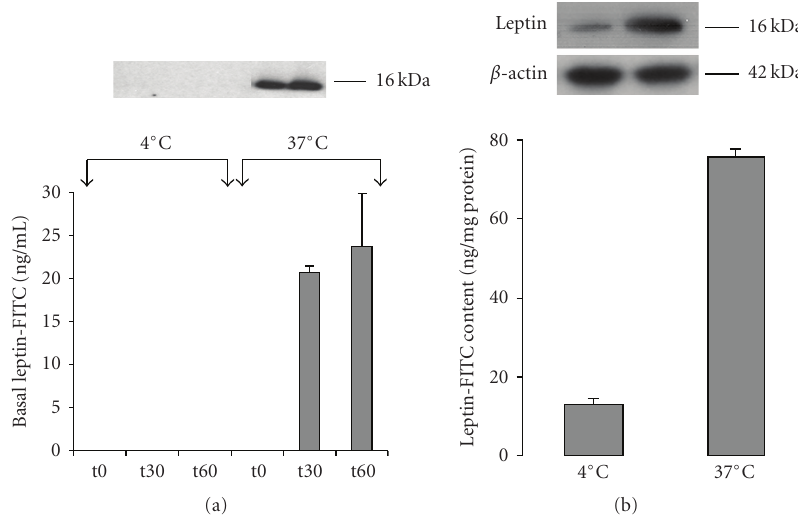
Figure 2: E ff ect of temperature on leptin transcytosis. Leptin-FITC (10 μ g/mL) was added to the apical compartment of Caco-2/15 cell monolayer which was kept either at 4 ◦ C or 37 ◦ C. Leptin concentration in the basal compartment was measured at 0, 30, and 60 minutes for both conditions. (a) Incubation at 4 ◦ C inhibits the transport of leptin to the basal compartment at all time points. (b) Leptin intracellular contents after 60 minutes of incubation showed a 85% decrease at 4 ◦ C as compared to 37 ◦ C. Bars represent mean values ± s.e.m ( n =